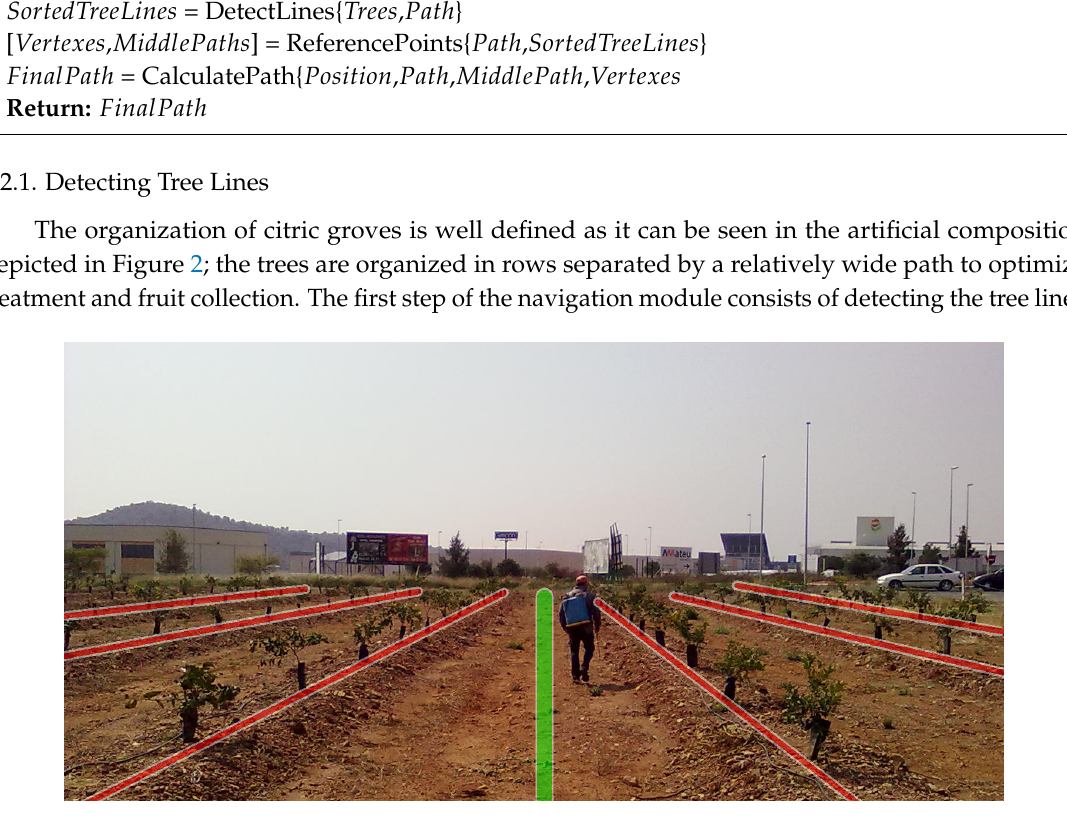
Figure 2. A farmer performing maintenance tasks in a young orange grove: The red lines stand for the rows of citrus trees (or just tree rows), and the green line stands for the path where the farmer is